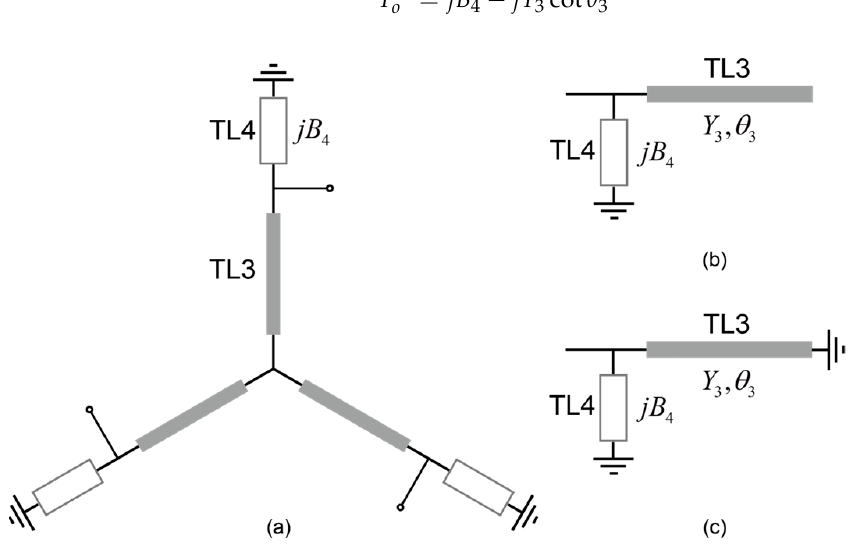
Figure 4. Equivalent circuit diagram of the neutralization section: ( a ) the star-shaped circuit; ( b ) the even mode circuit; and ( c ) the odd mode circuit.